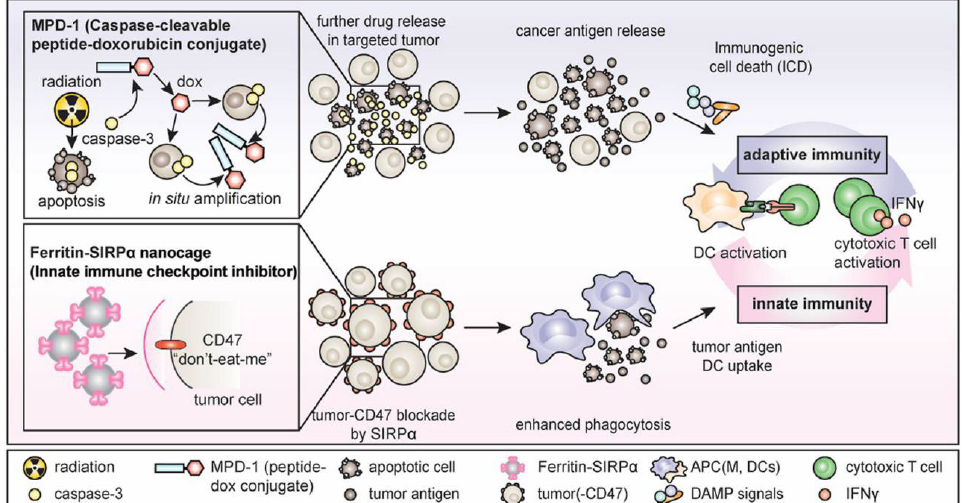
Figure 2. The combination of ferritin-SIRP α nanocages and caspase-cleavable peptide-doxorubicin conjugate [49].